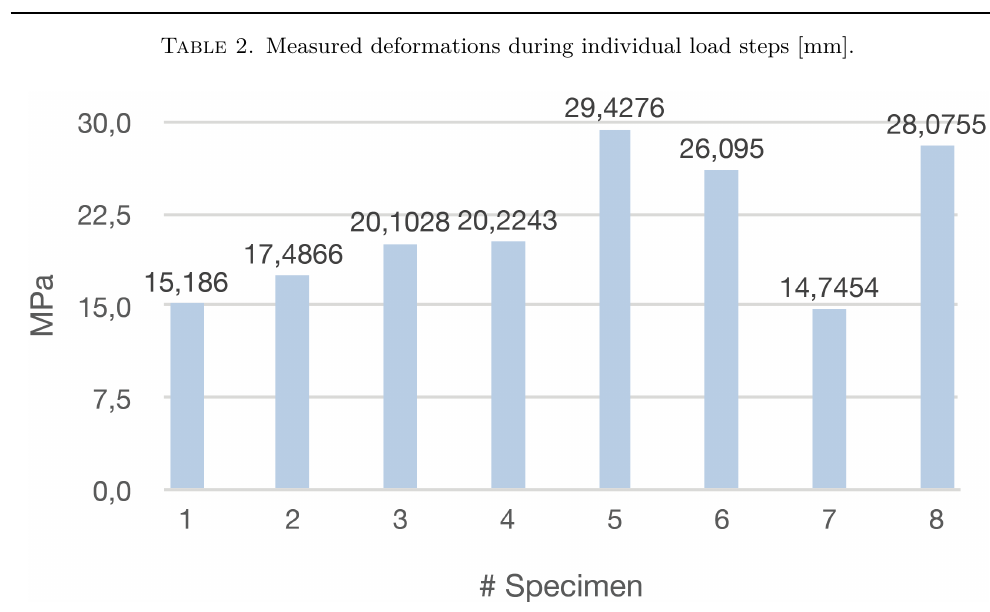
Figure 13. The compressive strength of experimentally investigated specimen.